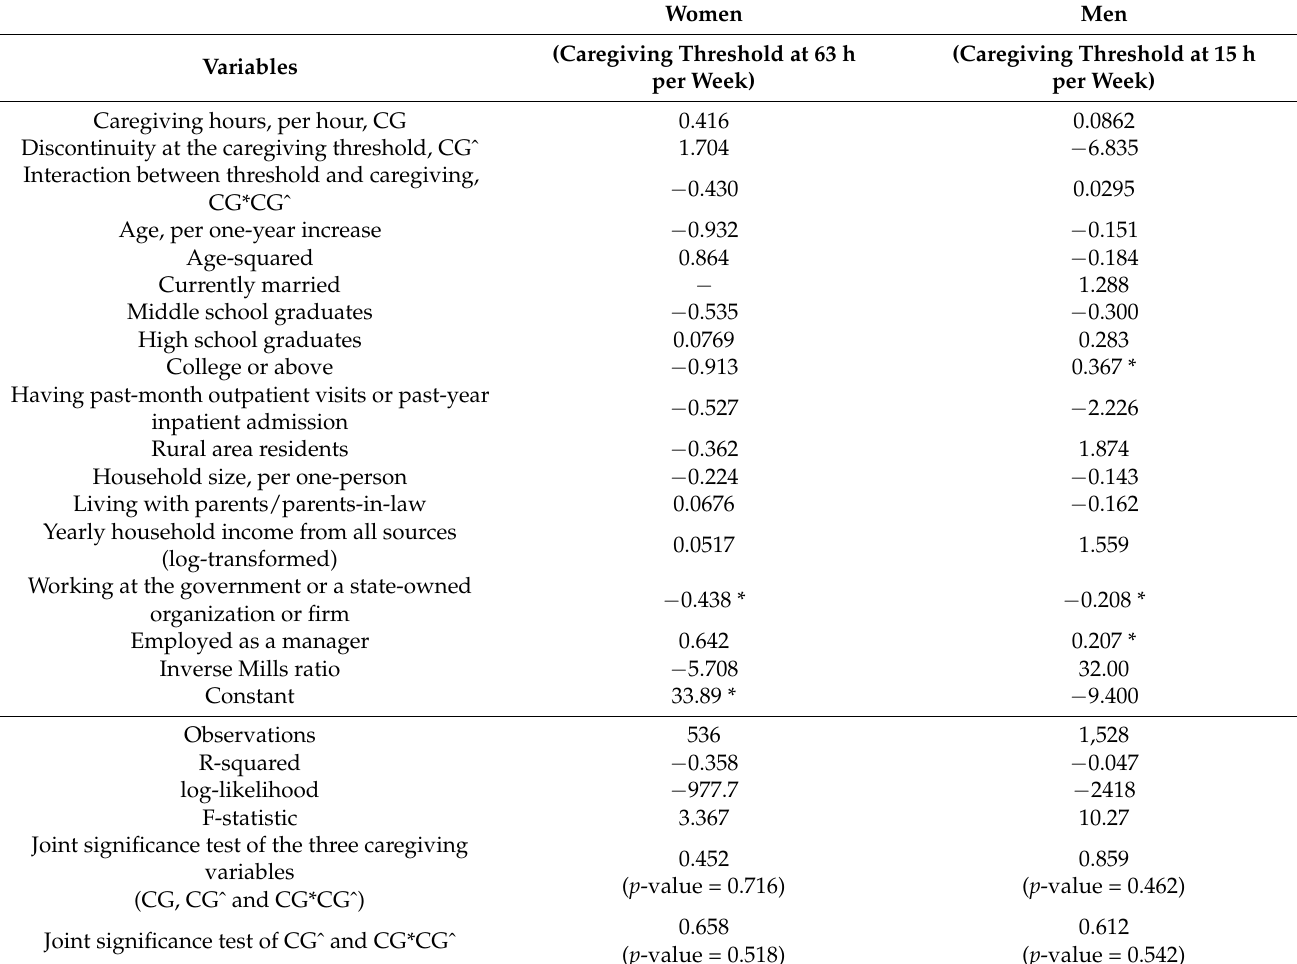
Table A1. Results of an instrumental variables analysis to predict log-transformed monthly income among women and